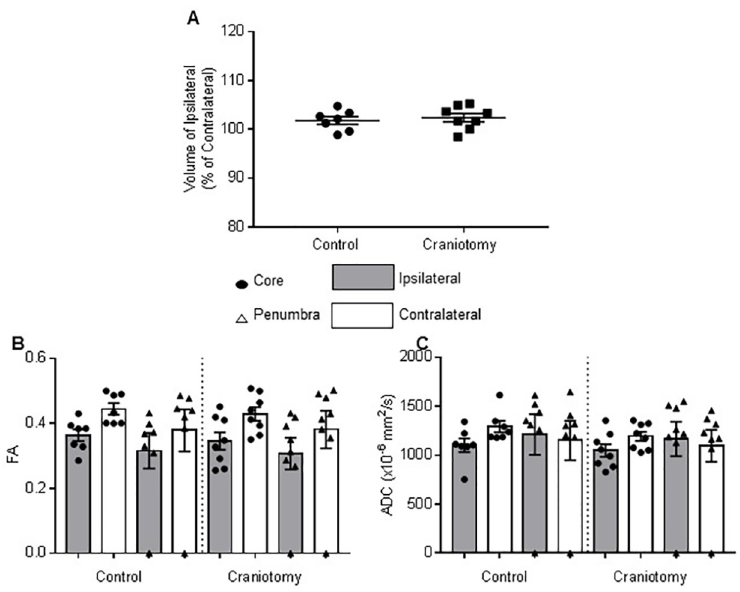
Fig 2. Effect of craniotomy on oedema formation at 48 hours post-MCAO. (a) The volume of the lesioned hemisphere as measured using T2-weighted MRI images, is displayed as a percentage of the unaffected hemisphere. There are no significant differences between the control and craniotomy groups. Craniotomy had no significant effect on the FA (b) and ADC (c) values of either the core or penumbra of the lesion as measured using DTI. Lines indicate mean ± SEM, closed circles are individual data points (control, n = 7; craniotomy, n =